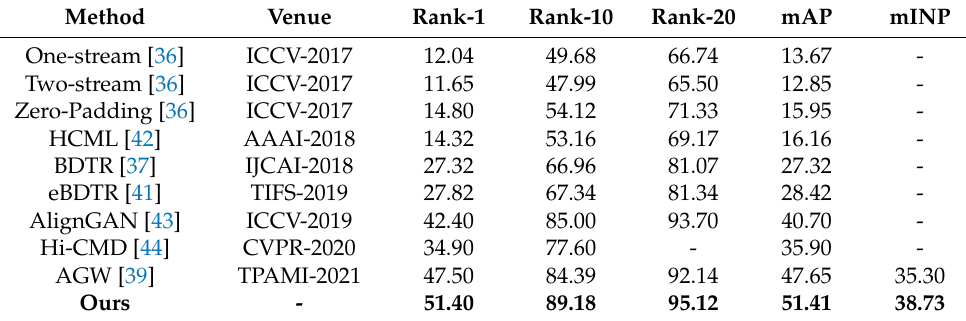
Table 1. Comparison of results in All-Search mode.